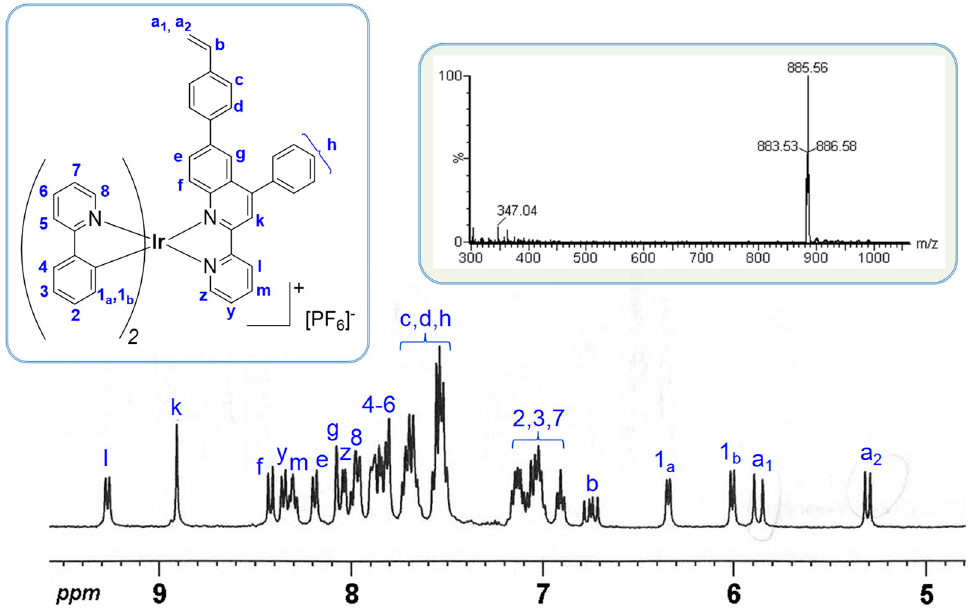
Figure 1. 1 H NMR spectrum of complex [(PPy) 2 Ir(VQPy)(PF 6 )] in DMSO- d6 . The inset shows the respective MS-ESI spectrum.